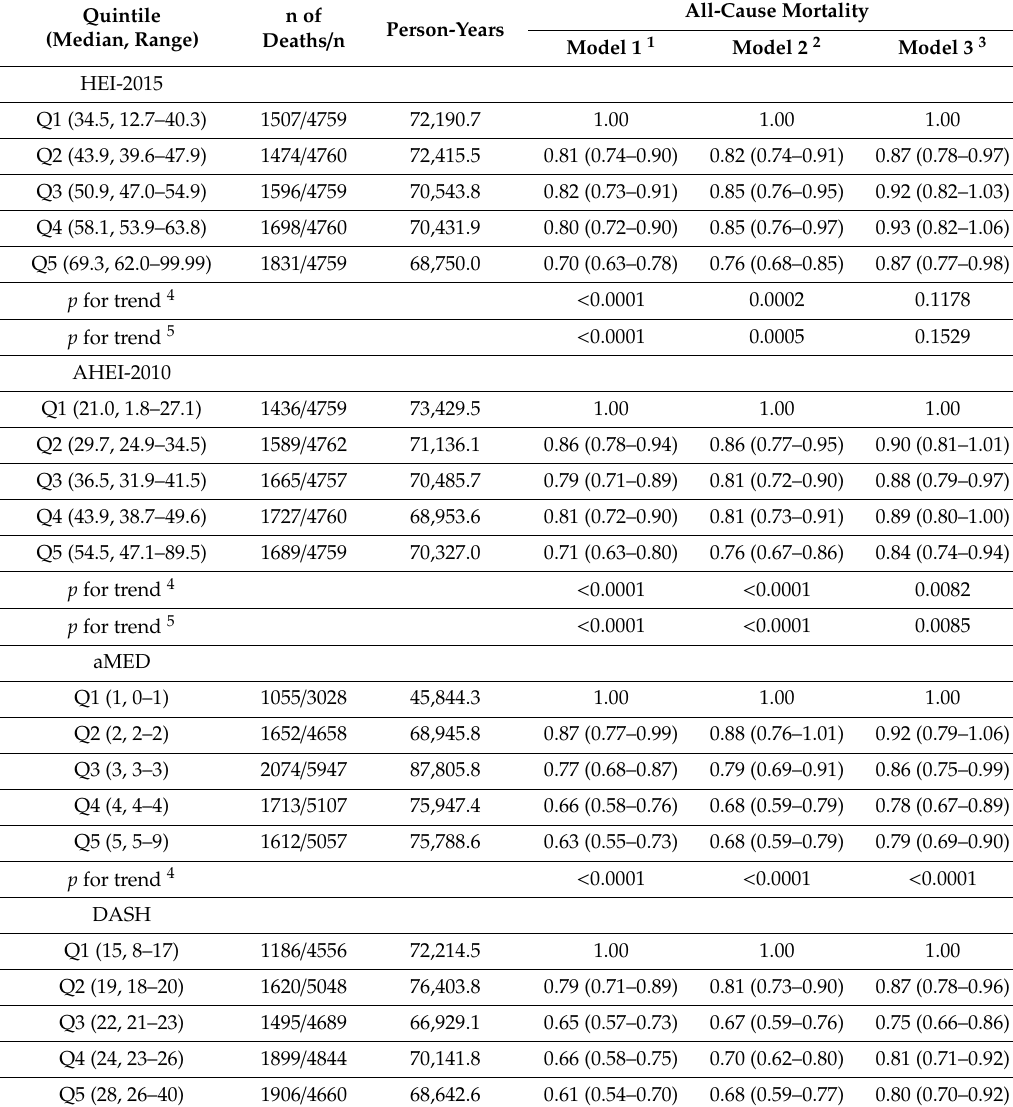
Table 3. Multivariable-adjusted hazard ratios and 95% confidence intervals for all-cause mortality according to quintiles of diet quality index scores and dietary total antioxidant capacity (mg VCE / day). Quintile n of (Median, Range) Deaths / n